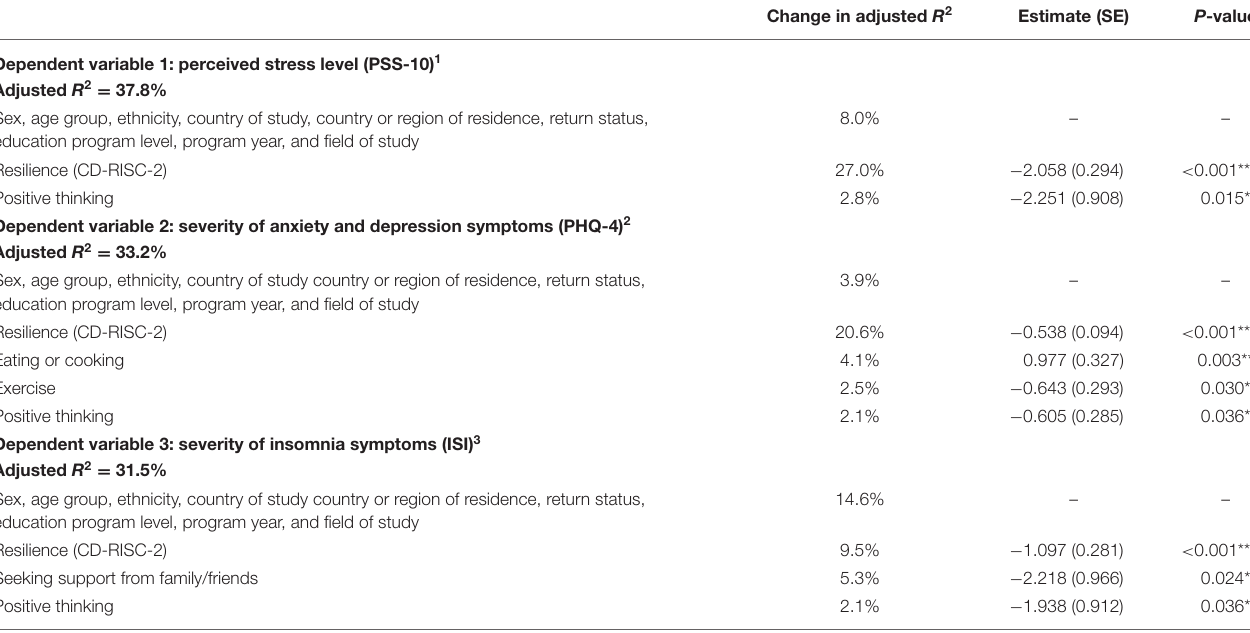
TABLE 6 | Resilience and coping strategies as predictors of mental health impacts identified by forward stepwise multiple regression analysis ( n = 124). Change in adjusted R 2 Estimate (SE) P